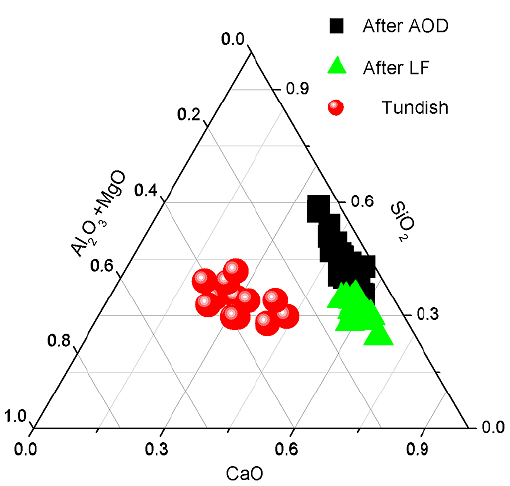
Figure 4. Composition distributions of inclusions (size larger than 5 μm ) at the different stages.